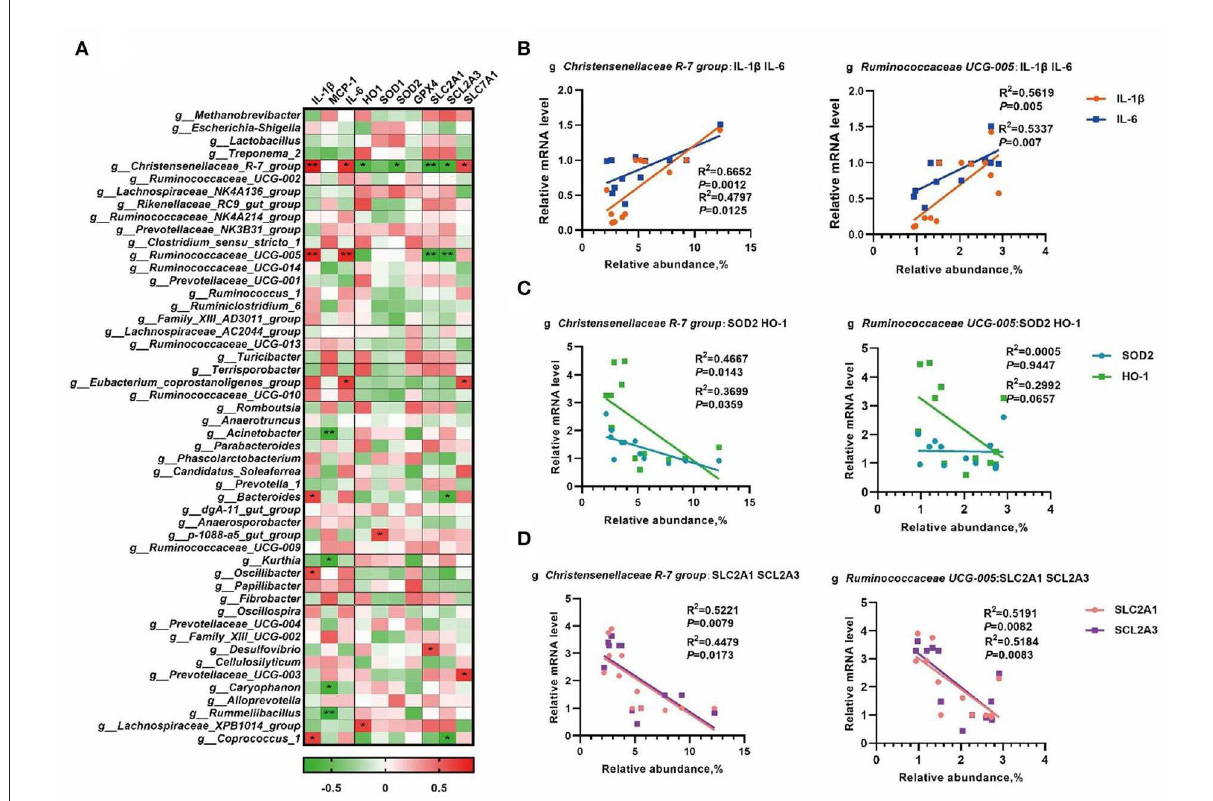
FIGURE6 The correlation analysis of the gut microbiota and placental gene expression. The correlation analysis between the abundance of the top 50 microbial genera and placental gene expression by Spearman’s correlation analysis (A) , linear regression analyses between genera and placental mRNA expression of inflammatory cytokines (B) , mRNA expression of antioxidative genes (C) , and expression of genes involved in the regulation of nutrient transport in placenta (D) . *, p < 0.05; and **, p <